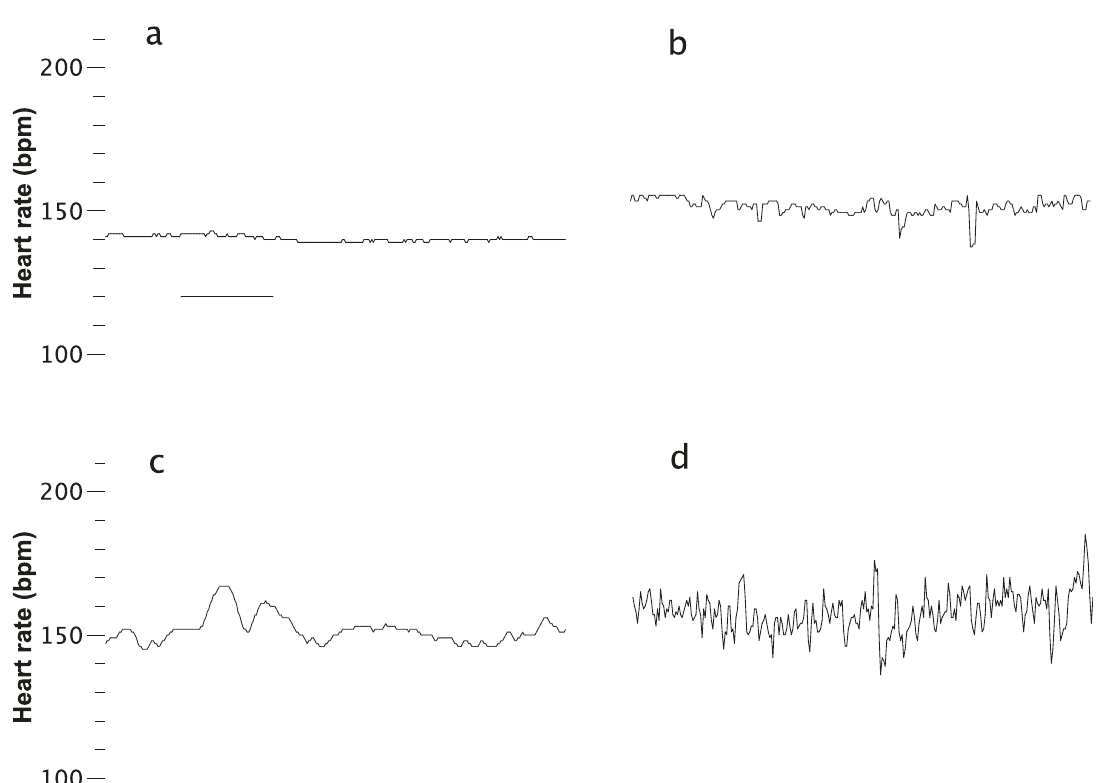
Fig. 4 Lack of successive increases in heart rate predict increased risk of death. Four 10 min heart rate records that correspond to increasing death risk with a decreasing number of successive increases in heart rate. The record in a had no successive increases and re fl ected a 20.6-fold increased risk of death. b – d Show records with 15, 30, and 60 successive increases in heart rate and re fl ected fold-increased risks of death 3.5, 1.1, and 0.6,